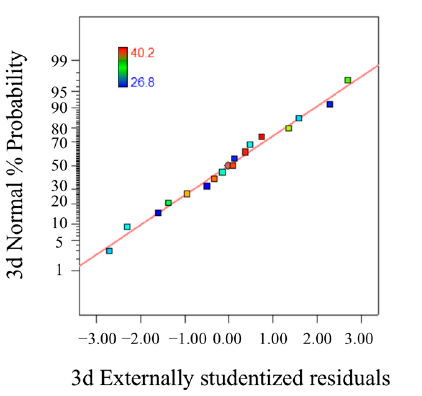
Figure 5. Normal probability plots of residuals (3/28 d).